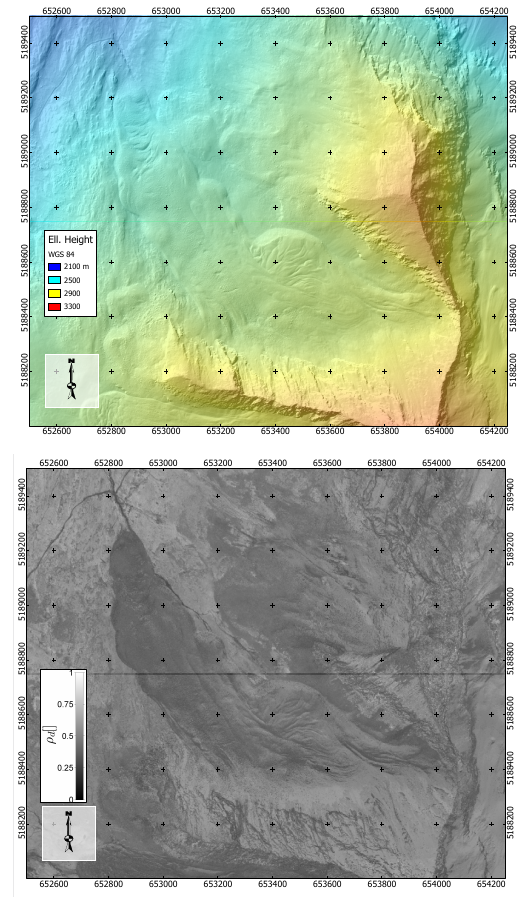
Figure 7: Digital surface model and shaded relief of the Äußeres Hochebenkar area (top) and diffuse Lambertian reflectance (bot- tom), derived by the results of FWF analysis. Similar to Ölgrube (Figure 6), the outline in the lower part and the Western outline of the rock glacier is well represented in the reflectance image.